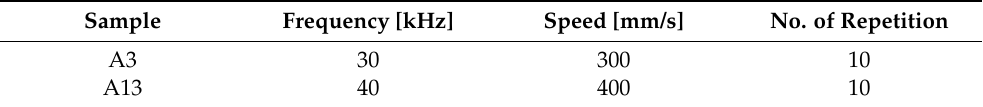
Table 2. Variable parameters used for microtexturing design octagonal donut shape (design type A).